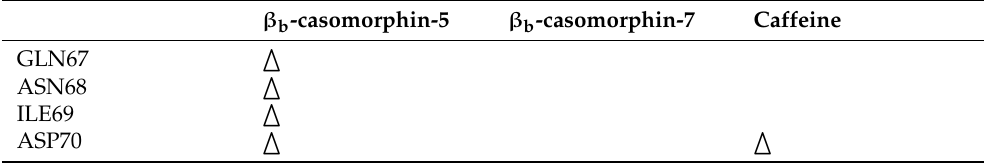
Figure 2. Predicted binding mode of opioid peptides to AChE (PDB: 2 × 8B). ( a ) β b -casomorphin-5, ( b ) β b -casomorphin-7, and ( c ) caffeine. The best-scored docking pose is shown. The crystal structure of human butyrylcholinesterase is also well characterized through X-ray studies and consists of a catalytic triad (Glu325, Ser198, and His438), an anion site (Trp82, Tyr128, and Phe329), a peripheral anionic site (Asp70 and Tyr332), an oxyanion hole (Gly116, Gly117, and Ala199), and an acyl pocket (Val288, and Leu286) [43]. As shown in Table 5 and Figure 3, β b -casomorphin-5, β b -casomorphin-7, and caffeine have interactions with the catalytic triad (His438, Ser198) and the peripheral anionic site (Asp70 and Tyr332). Moreover, the opioid peptides showed interactions with the anion site (Trp82 and Phe329) but not with the oxyanion hole. Notably, only β b -casomorphin-5 interacts with the acyl pocket (Leu286). Table 5. BChE (PDB: 4BBZ) interaction with compounds ( : hydrophobic interactions; (cid:97) : hydrogen (cid:31) bonds; • : electrostatic